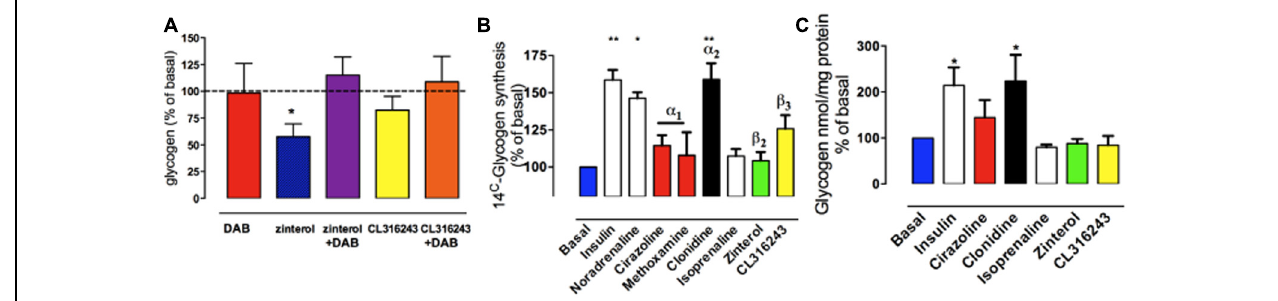
FIGURE 6 | The effect of adrenoceptor agonists on glycogen levels turnover and new synthesis in cultured astrocytes from chick forebrain. (A) Astrocytes were incubated for 2 h under basal conditions with no drug added, or for 2 h in the presence of zinterol or CL316243. DAB was added 20 min prior to the 2 h incubation (adapted from from Gibbs et al., 2006). (B) Glycogen synthesis assessed by [ 14 C]-glucose incorporation into glycogen in response to 3 hr stimulation with AR agonists, noradrenaline or insulin. (C) Glycogen levels expressed as % of basal after incubation with AR agonists or insulin. * P < 0.05; ** P < 0.001. (From Hutchinson et al.,